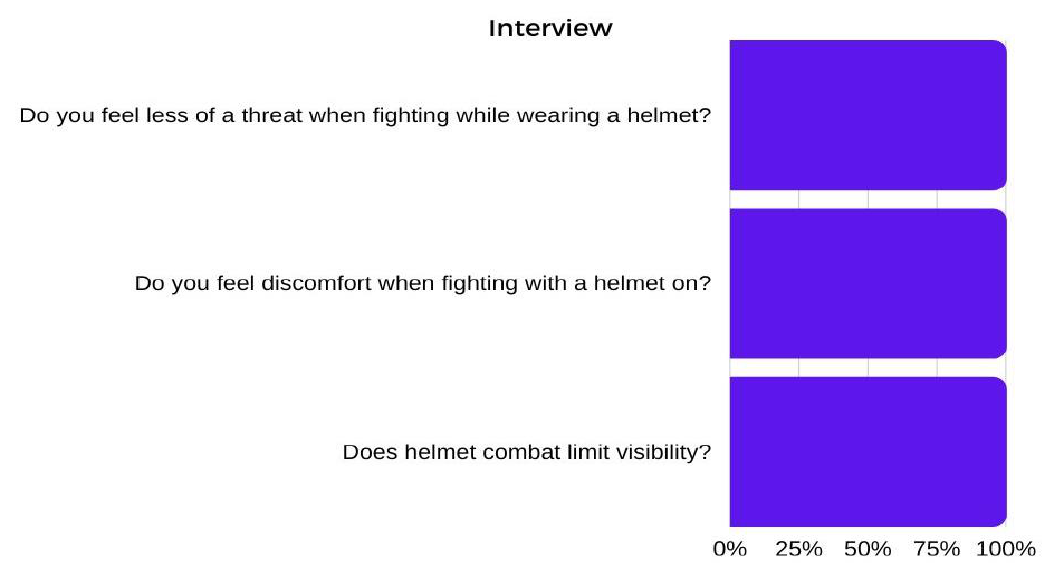
Figure 3. Results of the interview.